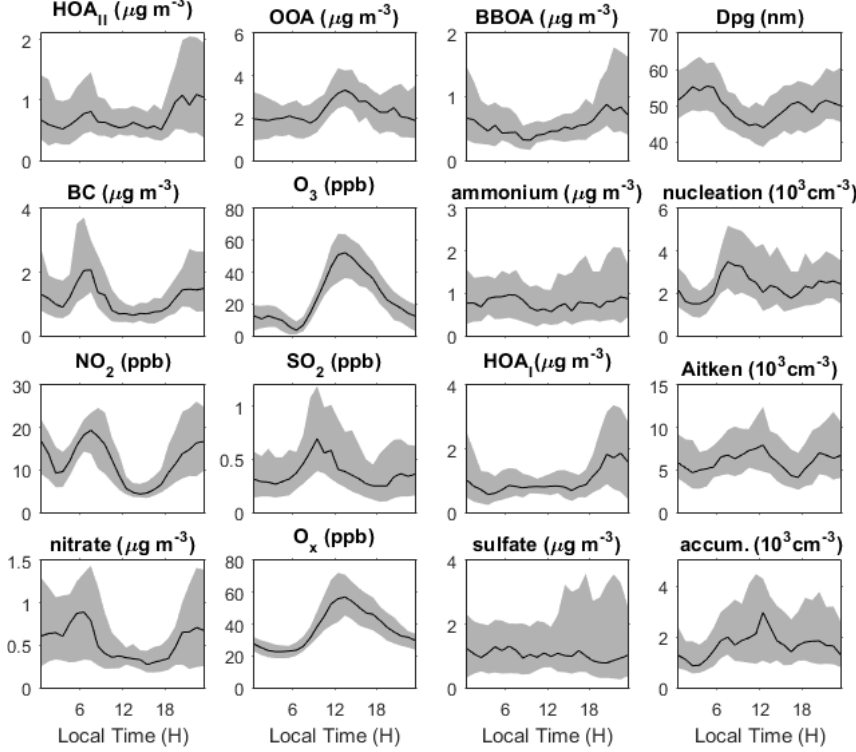
Figure 4. Diurnal trends for OA PMF factors (OOA, HOA I , BBOA, and HOA II ); black carbon, sulfate, nitrate, ammonium trace gases (NO 2 , SO 2 , and O 3 ); and geometric mean diameter, and submicrometer aerosol modes (nucleation, Aitken, and accumulation). Solid line represents the median and shaded areas represent the interquartile